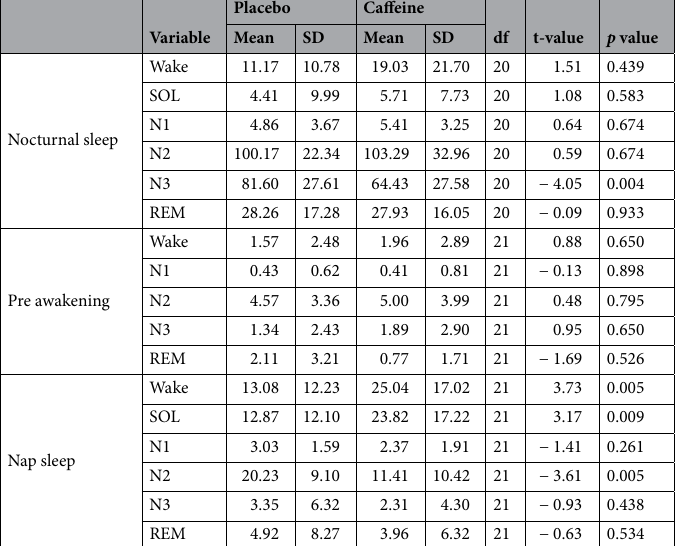
Placebo Caffeine